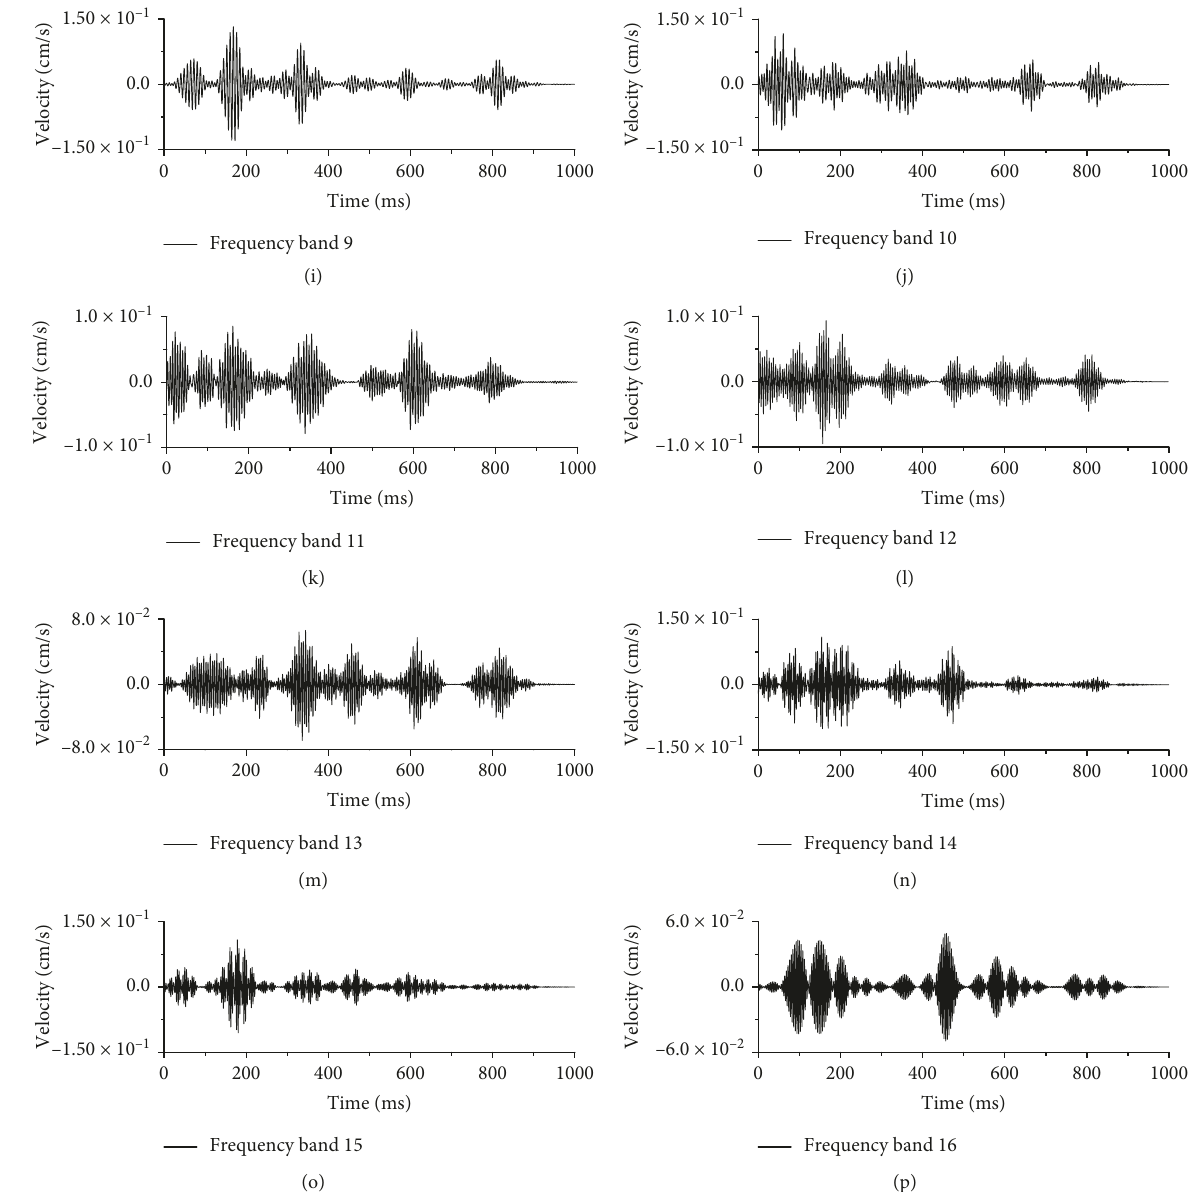
Figure 20: Optimized vertical wavelet packet decomposition: 1–16 band reconstruction